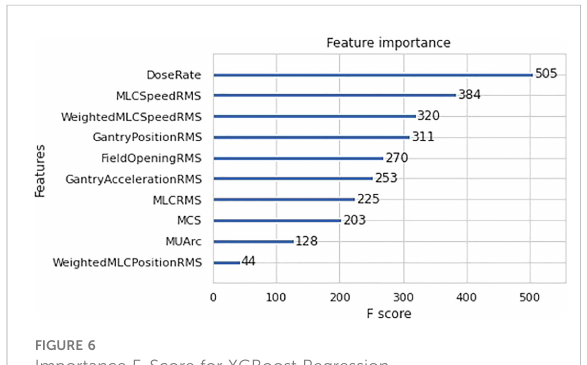
FIGURE 6 Importance F-Score for XGBoost